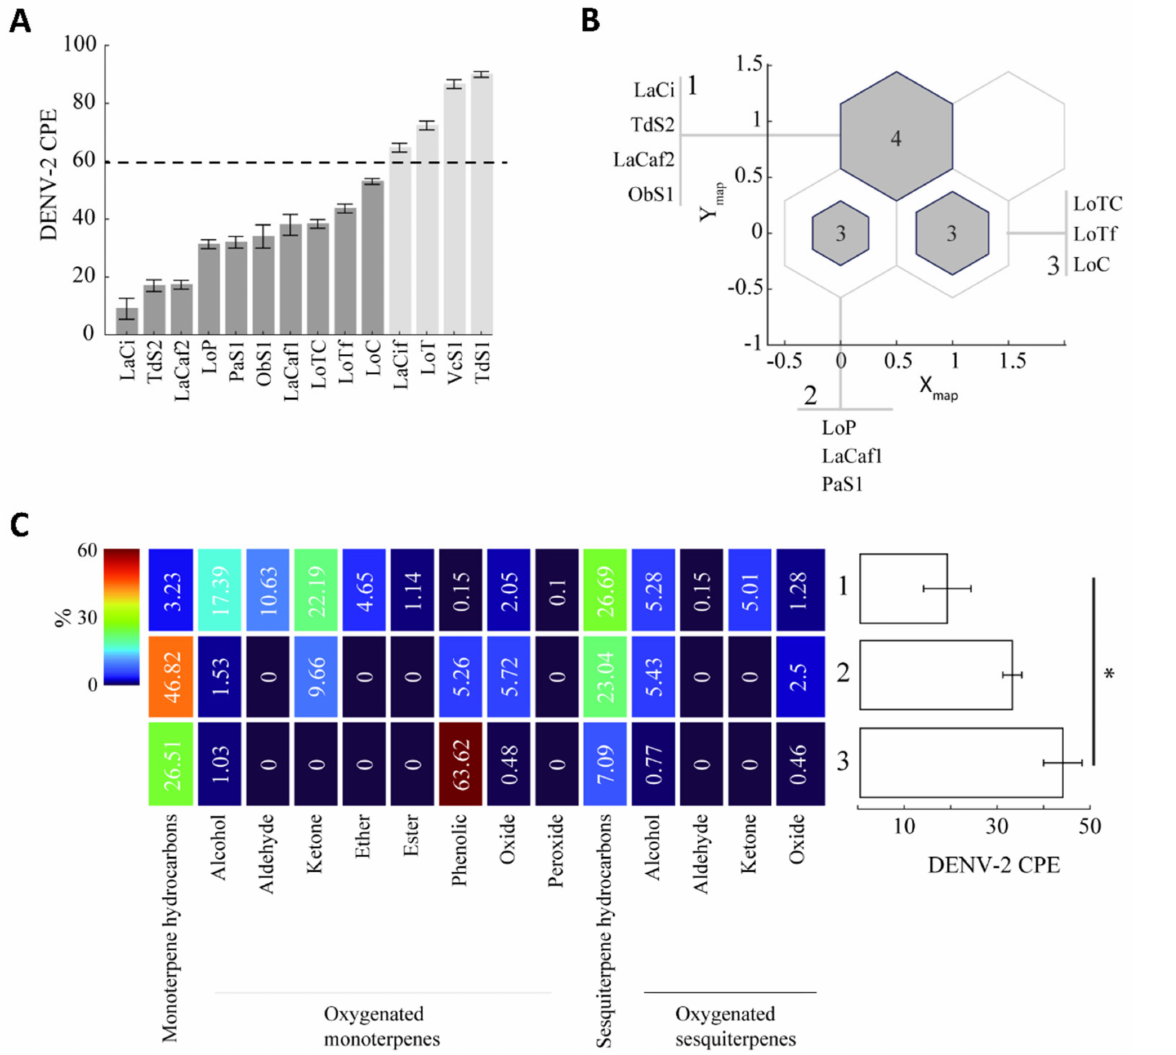
Figure 4. Clustering of essential oils based on monoterpene and sesquiterpene contents and their relation to antiviral activity. ( A ) . Cytopathic effect (CPE: %) of DENV-2 in Vero cells, EOs identifiers in Table 1. The dashed line indicates the CPE threshold for further clustering analysis, only EOs with CPE ≤ 60 (dark gray bars) were included. ( B ) . Clustering configuration of selected EOs in A using a 2 × 2 self-organized map. Three non-empty clusters were obtained. The number inside each cluster indicates the number of EOs it contains. ( C ). Left, heat map representing the chemical composition of clusters 1 (upper row), 2 (middle row), and 3 (lower row). Right, mean CPE of each cluster indicating statistical differences between clusters 1 and 3 (* One-way ANOVA: F 2,9 = 6.6092, p = 0.023, post hoc Tukey-Kramer test p =